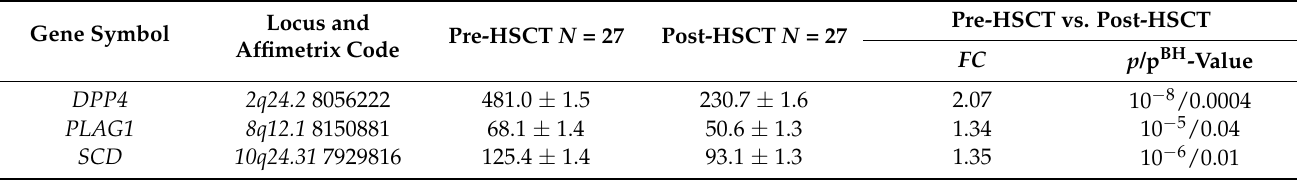
Table 6. Expression of genes associated with lipid metabolism in children undergoing the HSCT procedure.